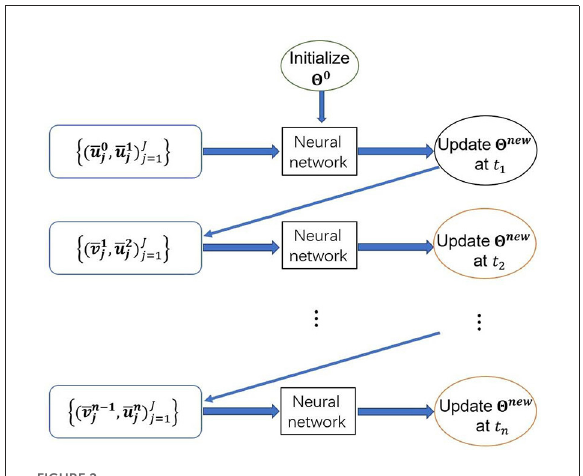
FIGURE2 Illustration of data usage and one epoch iteration to update 2